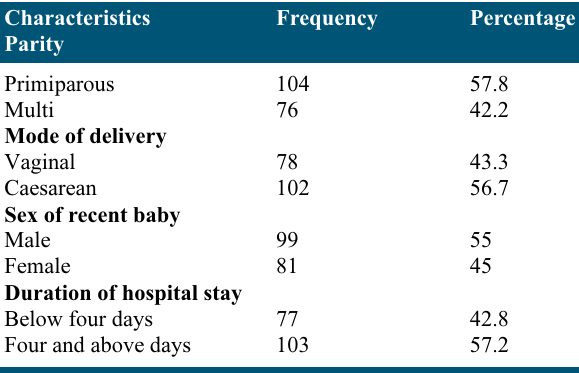
Table 3: Postnatal mothers' satisfaction on